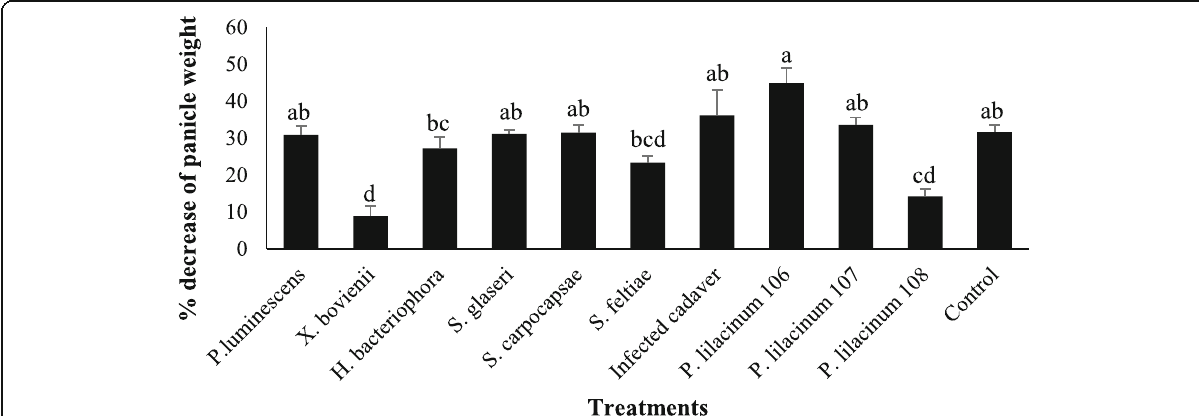
Fig. 2 The effect of treatments on the average decrease of panicle weight (%). Differences were significant at P < 0.05, and the same letters are not significantly